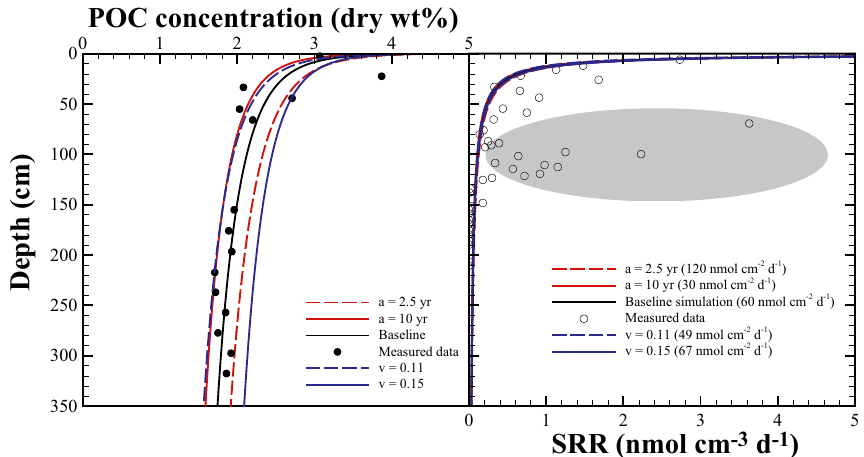
Fig. 6. Sensitivity analysis for the a and ν parameters of the reactive continuum model at Station A3. Circles indicate measured data and solid lines indicate best-fit values. Additional lines represent variations in either the a or the ν parameter as depicted in the figure and the values in parenthesis indicate the sulphate reduction rates 0–1cm below the SWI. SRR=sulphate reduction rates. The shaded oval encloses the SRR values which may be influenced by